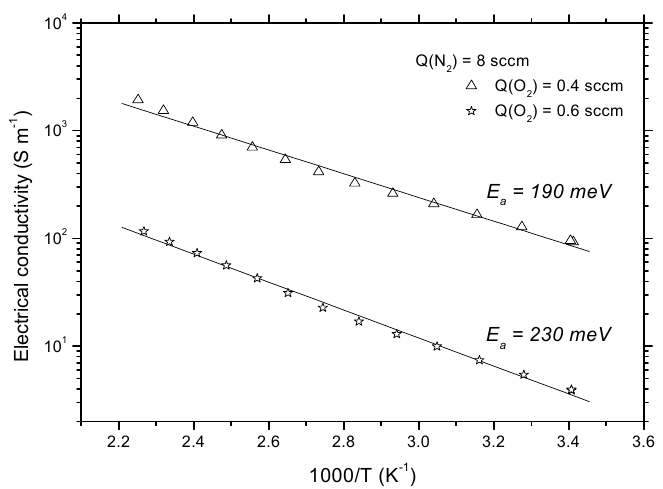
Figure 6. The electrical conductivity versus the inverse temperature of the oxynitride films deposited at Q (N 2 ) = 8 sccm with Q(O 2 ) = 0.4 and 0.6 sccm.